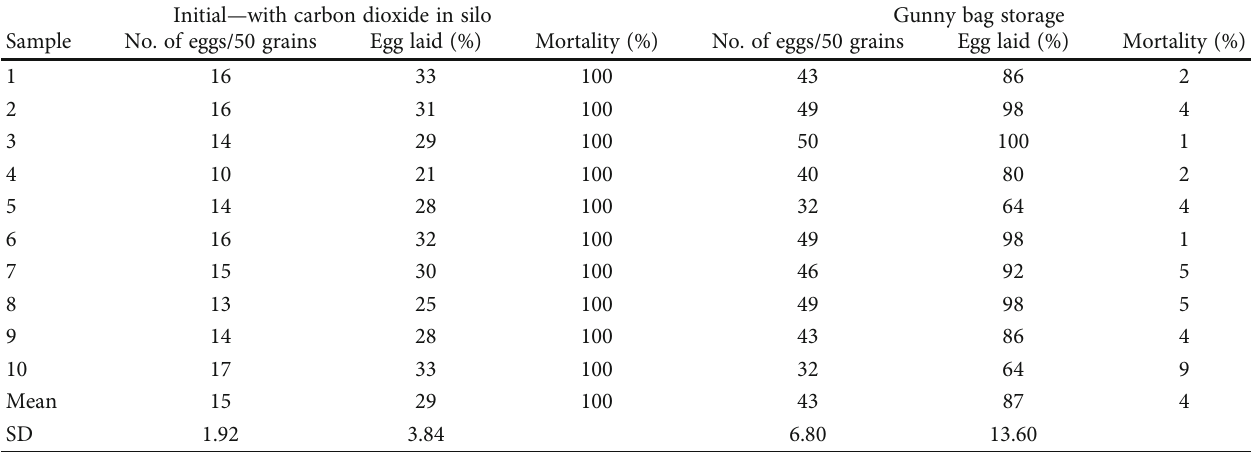
and gunny bag storage. 2